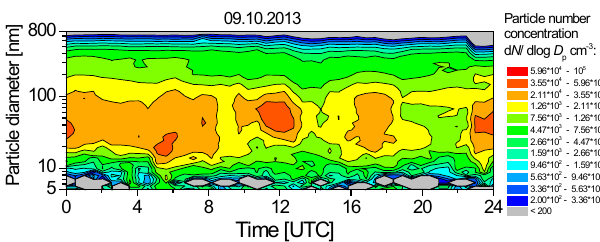
Figure 13. Aerosol number concentration measured with a TSMPS in Melpitz on 9 October 2013.